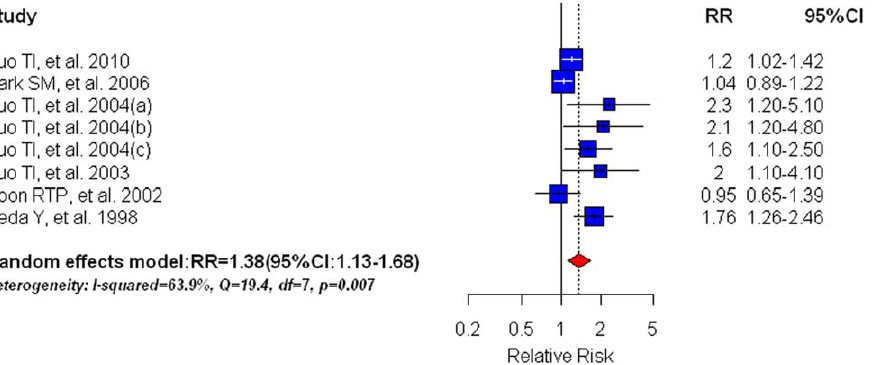
Figure 4. Summary estimate of relative risk (RR) for all-cause mortality in HCC patients with pre-existing diabetes mellitus compared with their non-diabetic counterparts. Squares represent study-specific estimates (size of the square reflects the study-specific statistical weight, i.e. inverse of the variance); horizontal lines represent 95% CIs; diamonds represent summary estimates with corresponding 95% CIs.